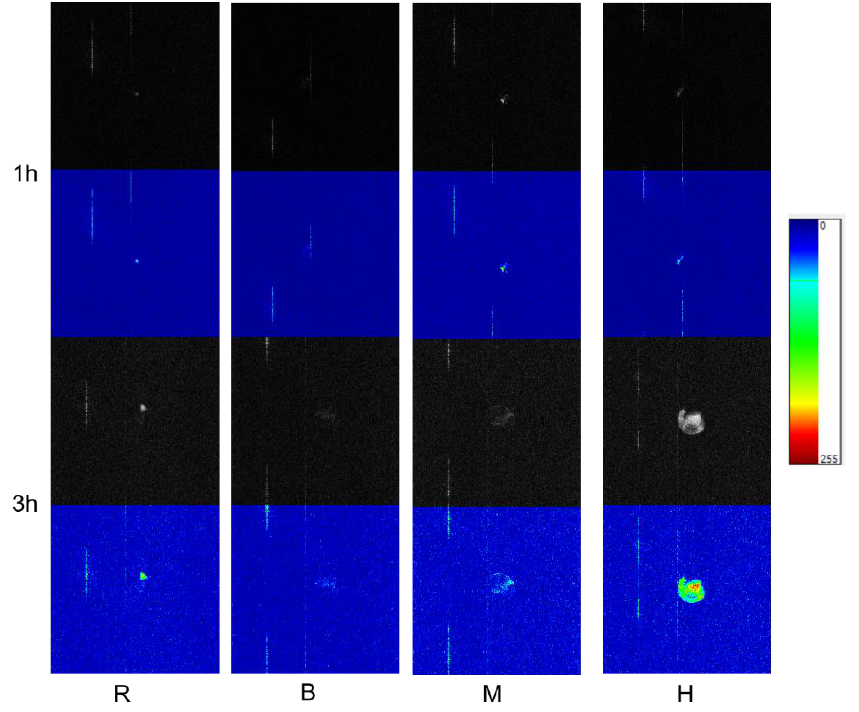
Figure 2. Low-field magnetic resonance imaging of EFS after different thermal processing. R: Raw; M: Microwave; B: Baking; H: Industrial infrared heating-assisted fluidized bed (IHFH). M: Microwave; B: Baking; H: Industrial infrared heating-assisted fluidized bed